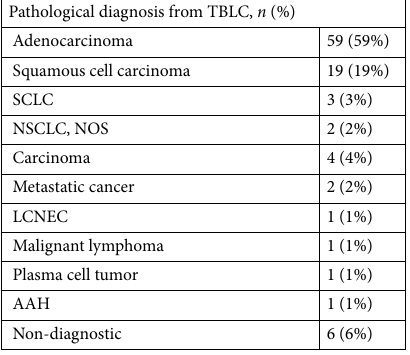
Table 2. Morphological diagnosis from TBLC. TBLC transbronchial lung cryobiopsy, SCLC small cell lung cancer, NSCLC non-small cell lung cancer, NOS not otherwise specified, LCNEC large-cell neuroendocrine carcinoma, AAH atypical adenomatous hyperplasia.